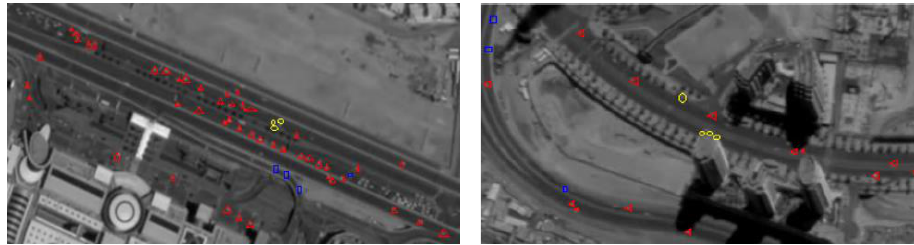
Figure 8. Final detection results. Truth Positive ( TP ) is labelled by red triangles. False positive ( FP ) is labelled by yellow ellipses. False Negative ( FN ) is labelled by blue